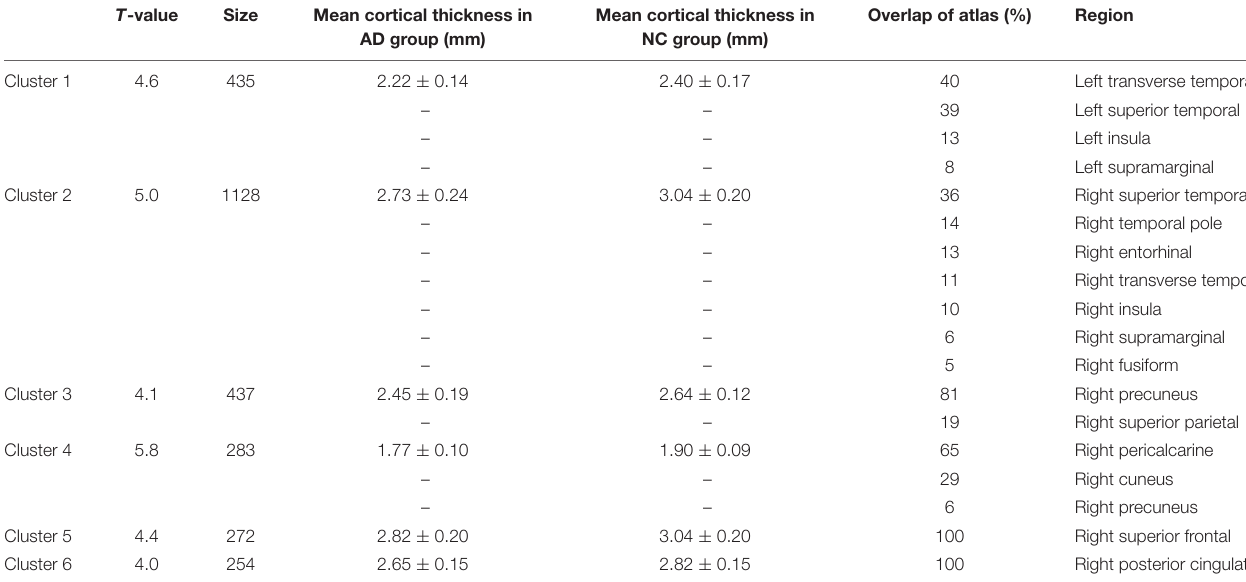
AD, Alzheimer’s disease; NC, normal control.